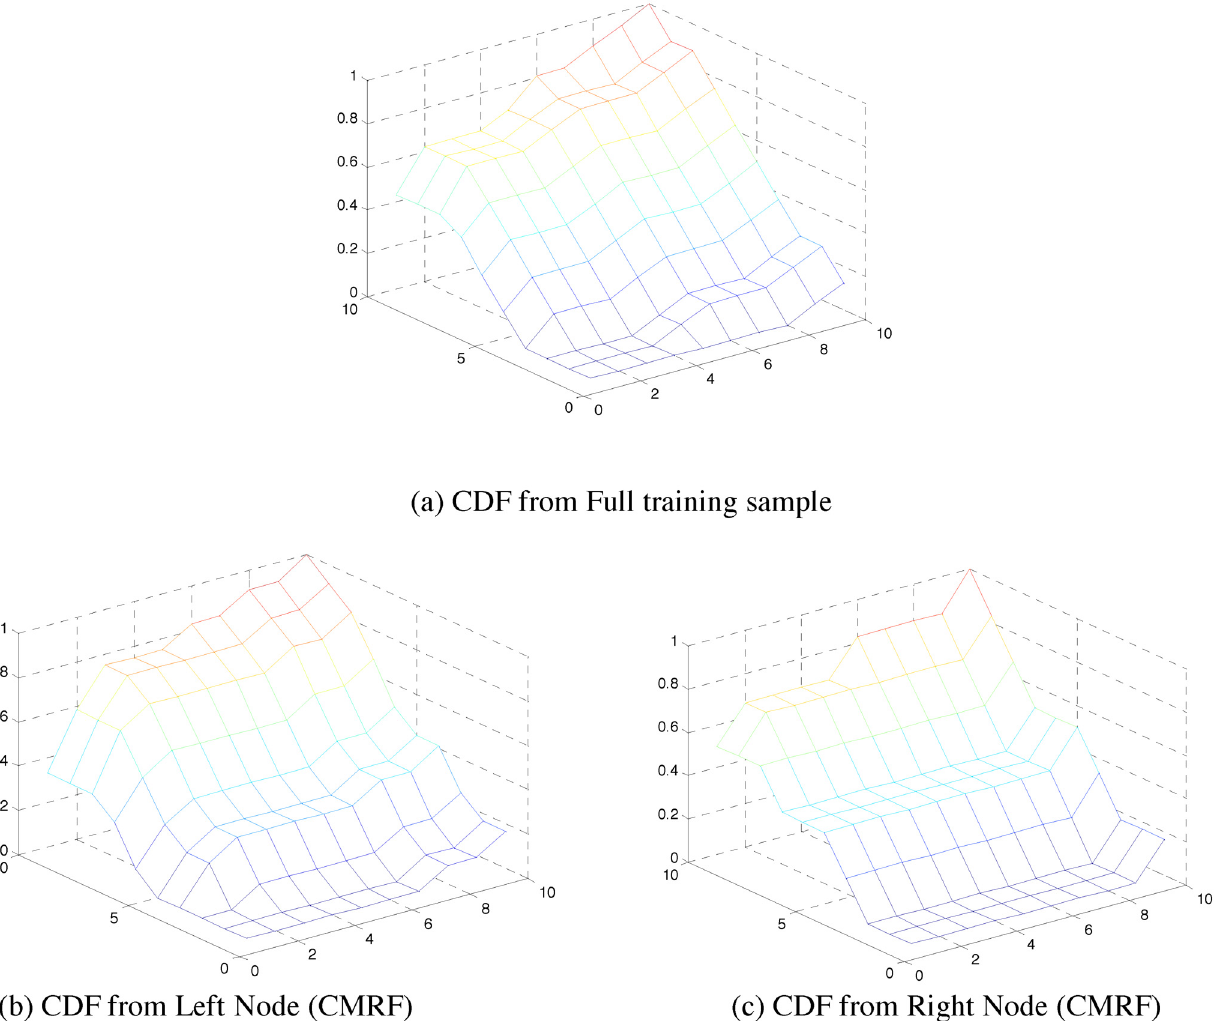
Fig 5. CDF created from left and right child node for a single split using CMRF. It is compared visually with the original CDF created from the training